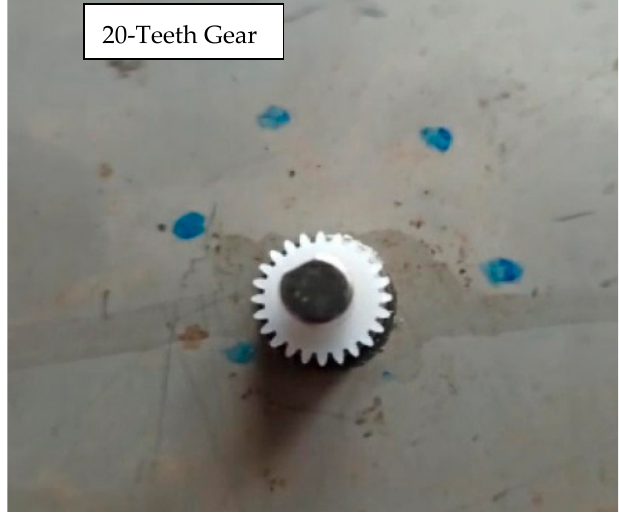
Figure 21. Teeth gear to slow down the RPM.